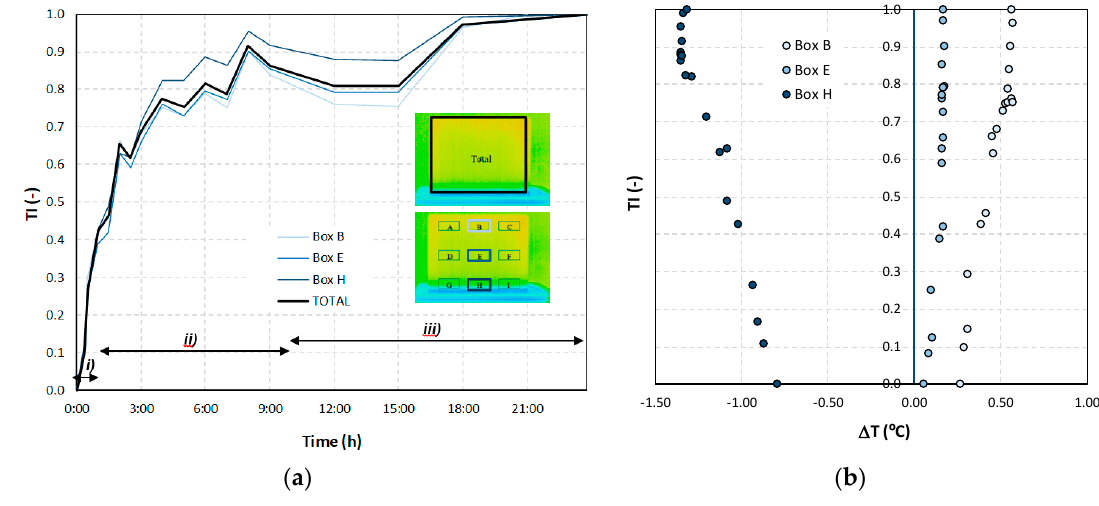
Figure 12. (a ) Thermal index ( TI ) vs. time; ( b ) TI vs. Δ T.